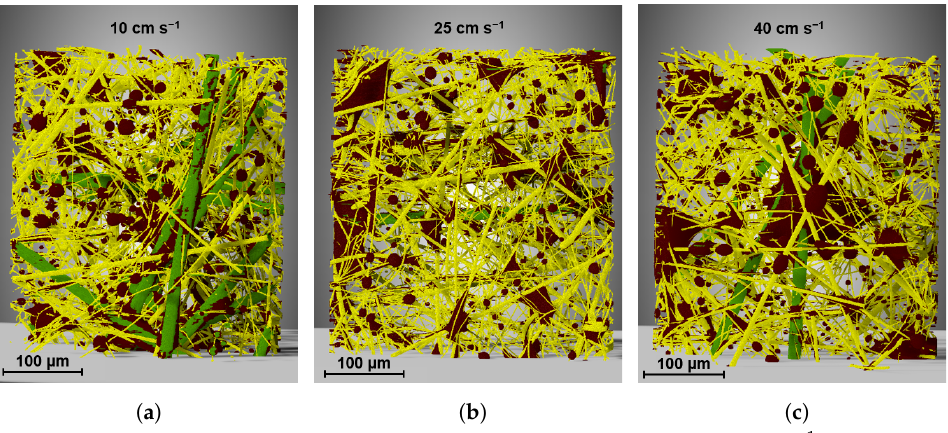
Figure 5. Exemplary pictures after the segmentation of ( a ) Sample 1 (10cms − 1 ), ( b ) Sample 3 (25cms − 1 ) and ( c ) Sample 6 (40cms − 1 ). The pictures were obtained by exporting 3D views with the utilized Dragonfly software. Micro glass fibers are shown in yellow, PET fibers in green and oil in brown color. View in the direction of air